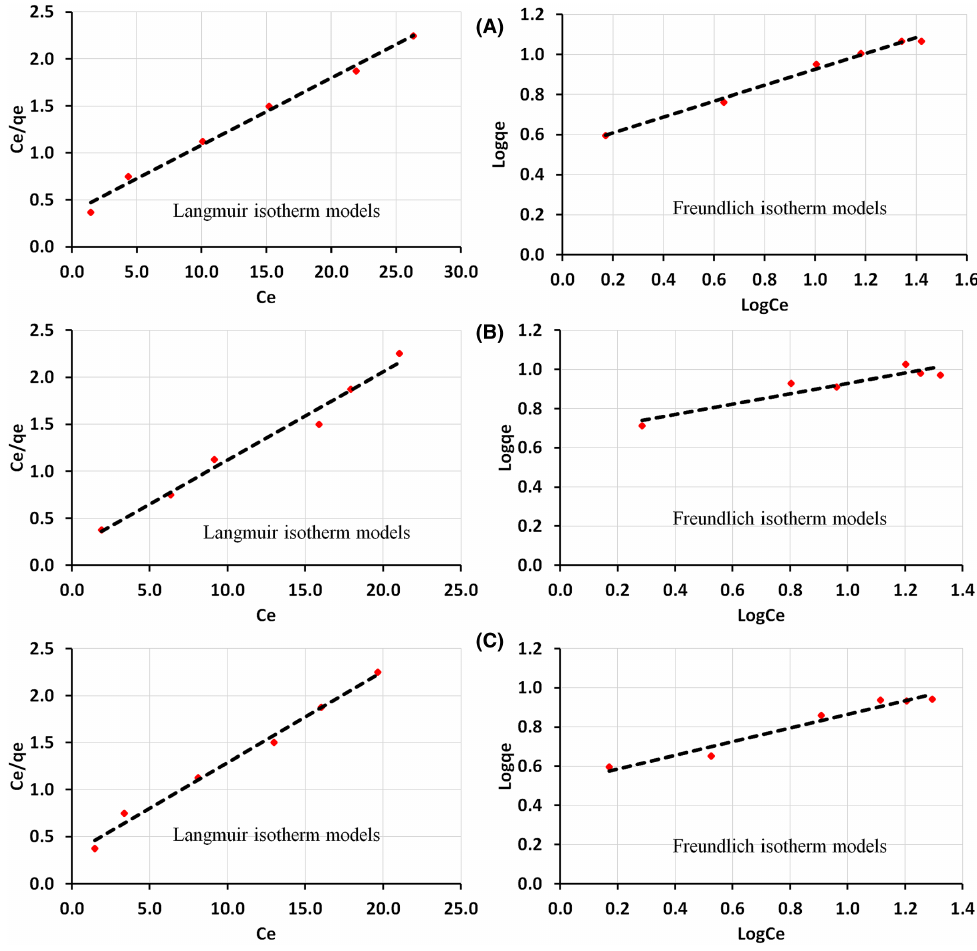
Figure 6 Adsorption study of phenol over (A) CS – SiO 2 /CaCO 3 nanocomposite (B) RHSiO 2 (C) ESCaCO 3 . Showing both Langmuir and Freundlich isotherm models. Adsorption condition: pH 5.4, and adsorbent dose of 0.15 g at 120 rpm under 60 min contact